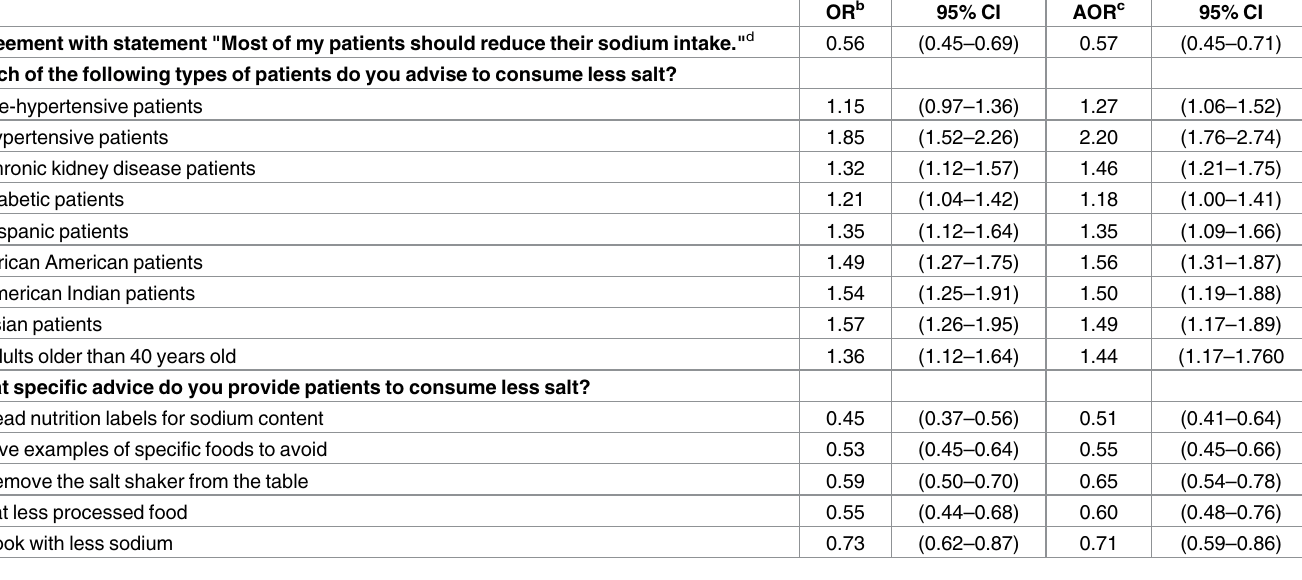
OR b 95% CI AOR c 95% CI